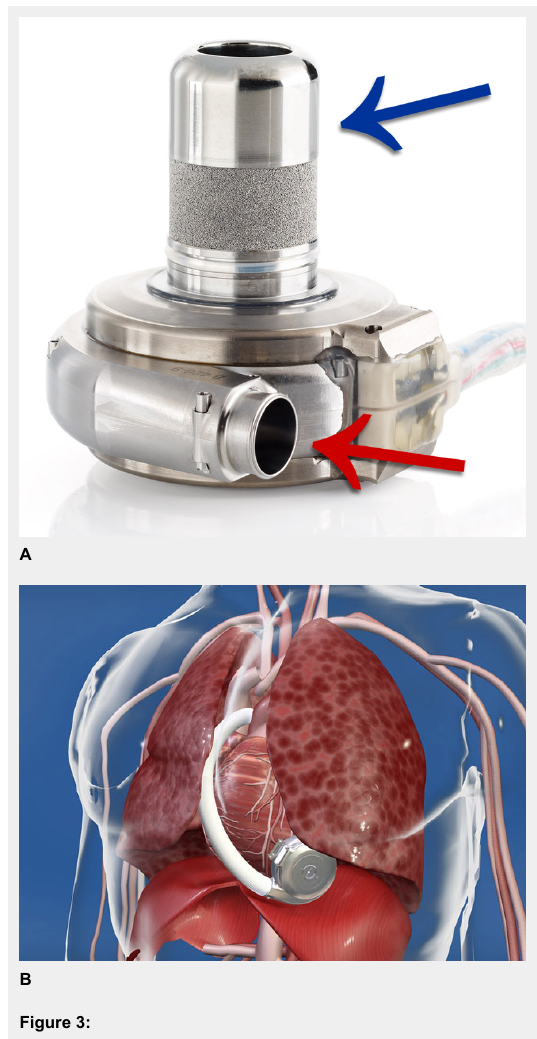
A : The HeartWare LVAD device with the tip of the device to be inserted into the LV apex (blue arrow) and the exit of the pump to be connected to the vascular prosthesis (ascending aorta; red arrow) (HVAD ® pump. © HeartWare. Reprinted with permission). B : In situ position of the device in the thoracic cavity (HVAD® pump in pericardial space. © HeartWare. Reprinted with